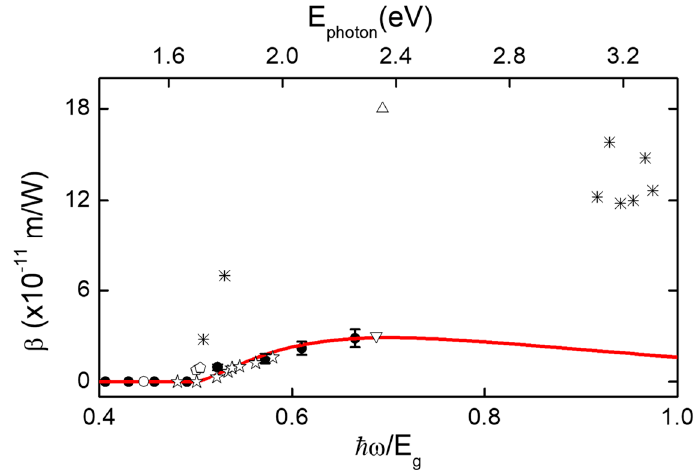
Figure 2. Experimental (solid circles) and theoretical (line) dispersion of the two-photon absorption coefficient ( β ) of GaN with respect to its band gap energy of 3.39 eV. Literature data are plotted as a hollow circle [37], star [38], pentagons [39], asterisks [40], up-triangle [41], and down-triangle [42].